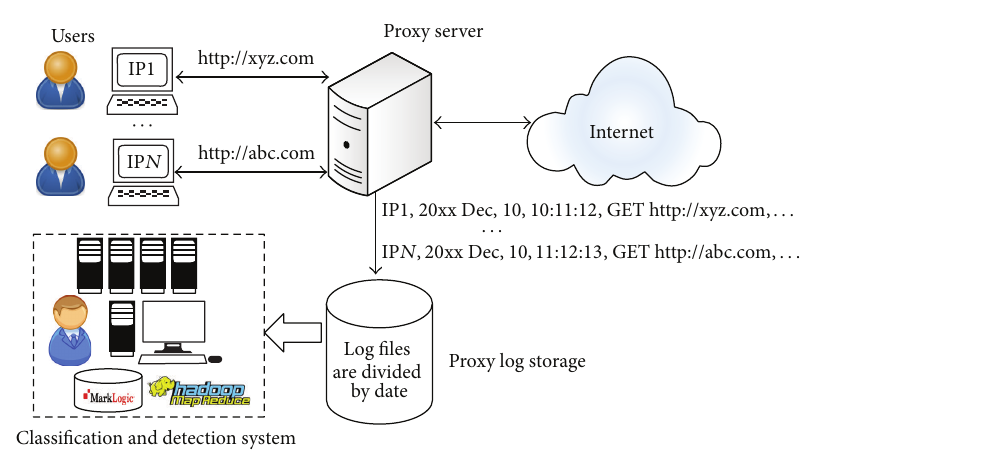
Figure 11: Experiment environment.